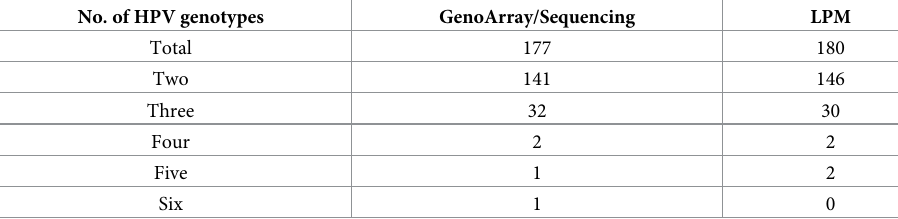
Table 7. Numbers of multiple genotypes identified by GenoArray/Sequencing and LPM assay. No. of HPV